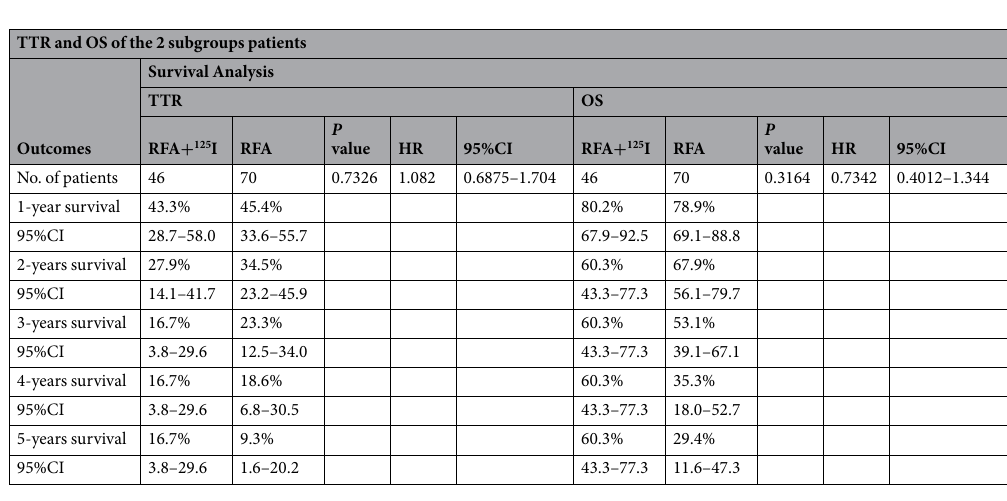
Table 2. The TTR and OS of the 2 subgroups